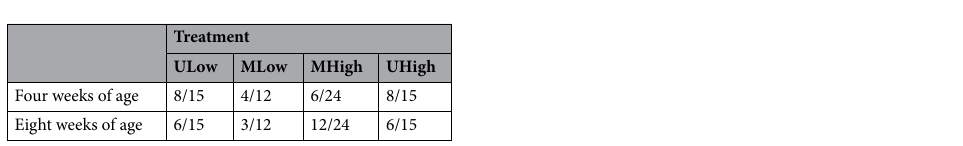
Figure 1. Experimental design of treatments, group composition and milk allowance. Sample size is the number of calves included in statistical analysis.